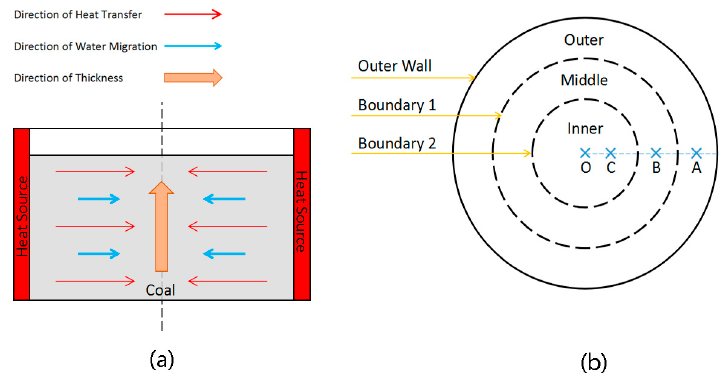
Figure 2. The sidewall drying device: ( a ) Heat and mass transfer direction in the device; ( b ) circular tank internal partition and thermocouple insertion positions.